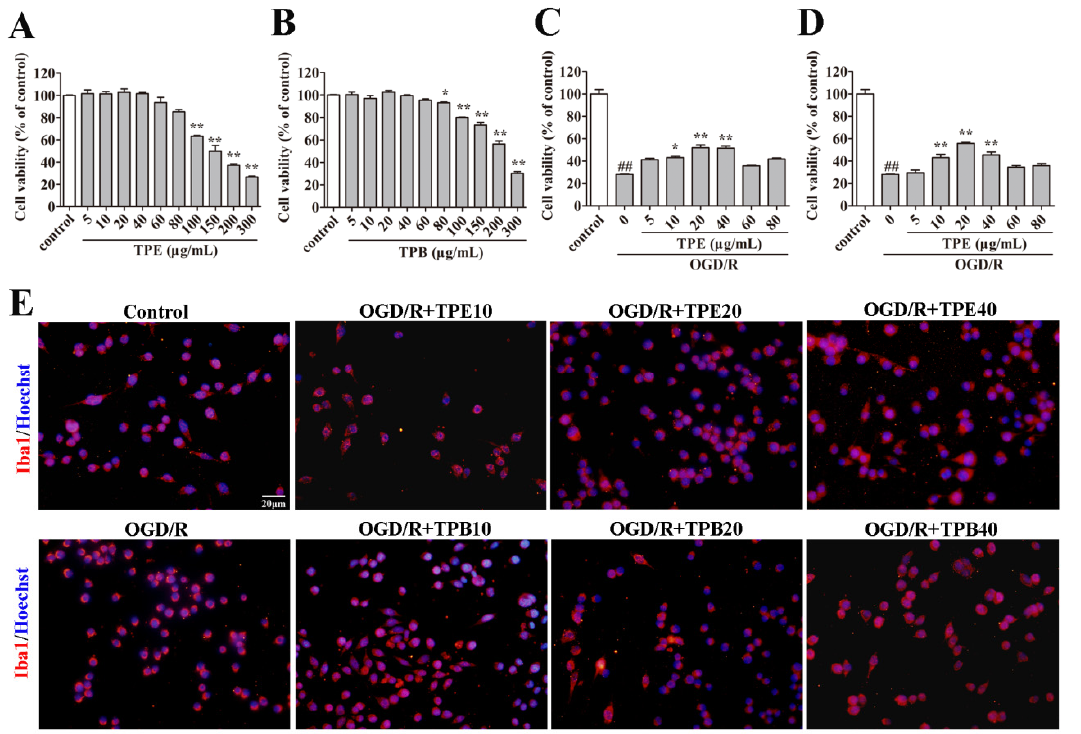
Figure 2. Effects of TPE and TPB on BV2 microglial cells. ( A , B ) Cell toxicities of TPE and TPB. ( C , D ) The protective effects of TPE and TPB against OGD/R. ( E ) Morphological examination of BV2 microglial cells stained using Iba1 and Hoechst under a fluorescence microscope. ## p < 0.01 vs. control group; * p < 0.05, ** p < 0.01 vs. OGD/R group. OGD/R: oxygen-glucose depriva- tion/reoxygenation.